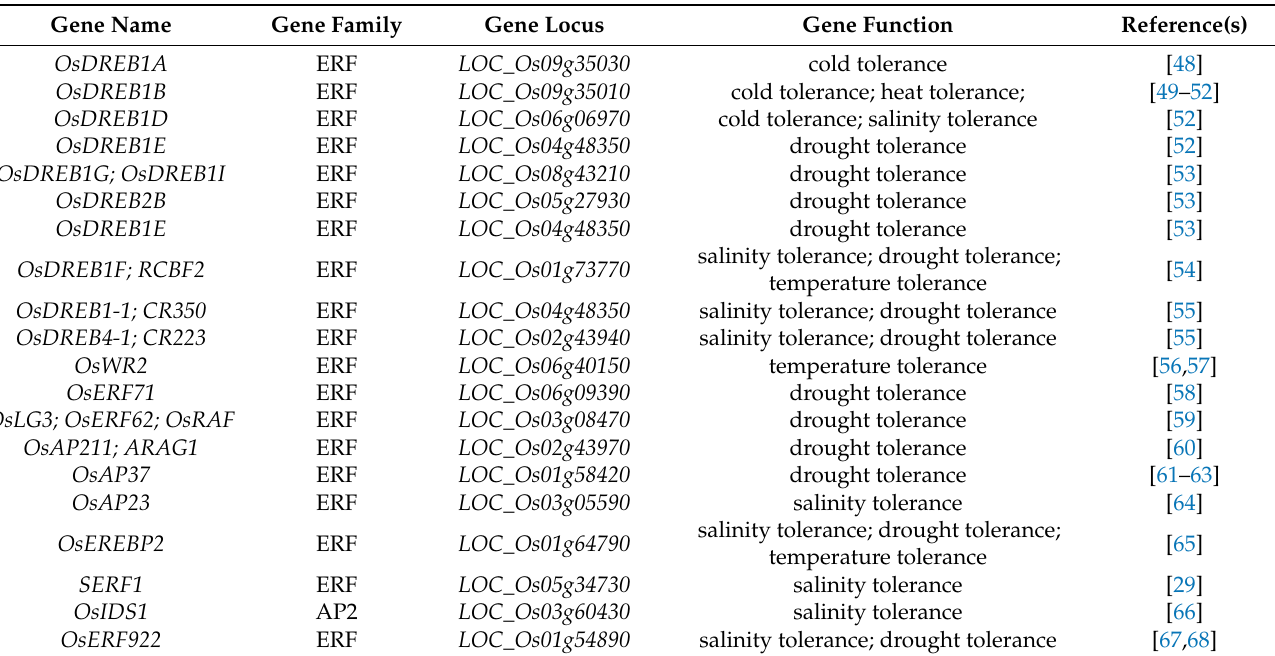
Table 9. Genes associated with abiotic stress in